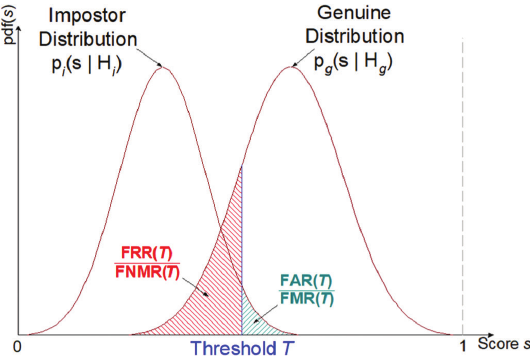
Figure 1 Visualization of FAR/FRR metrics and their threshold relation.